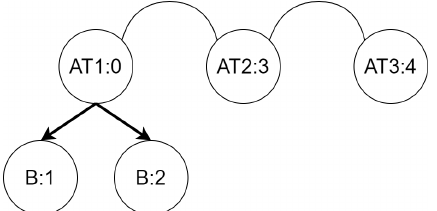
Figure 7. The initial state of a system for the scenario visualization example.